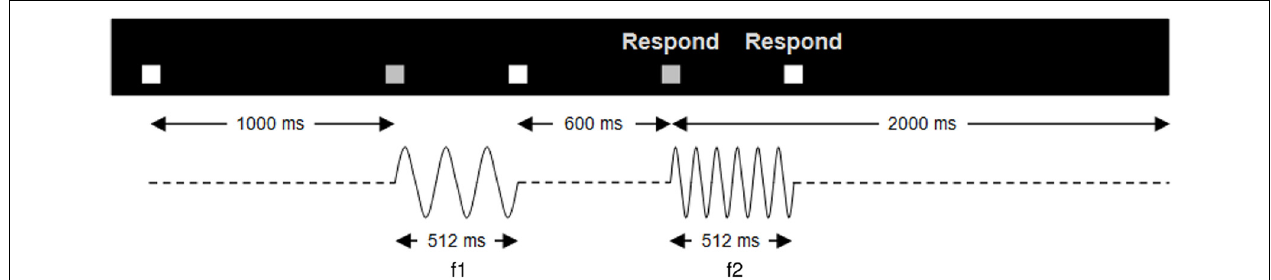
FIGURE 1 | Trial structure. Temporal structure of a single trial of the vibrotactile discrimination task. A pair of stimuli (f1, f2), each 512 ms in duration, separated by an ISI of 600 ms, was presented to the participant’s right index finger. The start of the trial was indicated by a white box, which turned gray when the vibrations were presented. Upon the onset of the second vibration, a respond screen appeared indicating that the participant could make a button press. Participants had 2 s in which to respond after the second vibration onset. Trials were presented in four sessions; two sessions of faster-slower and two same-different.